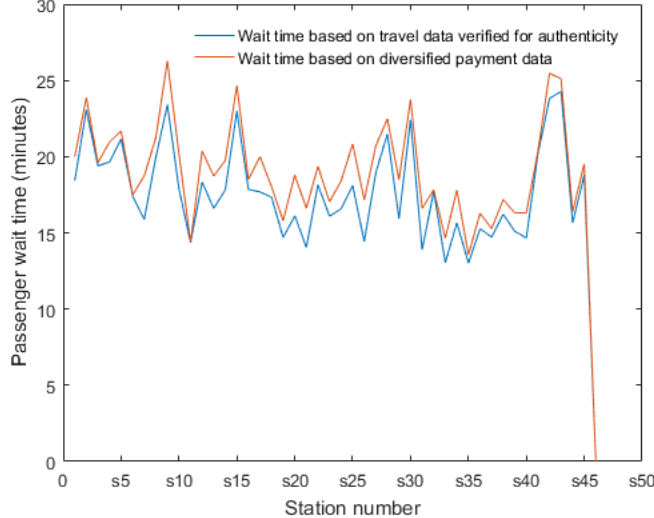
Figure 9. Comparison of passenger wait time (inbound).